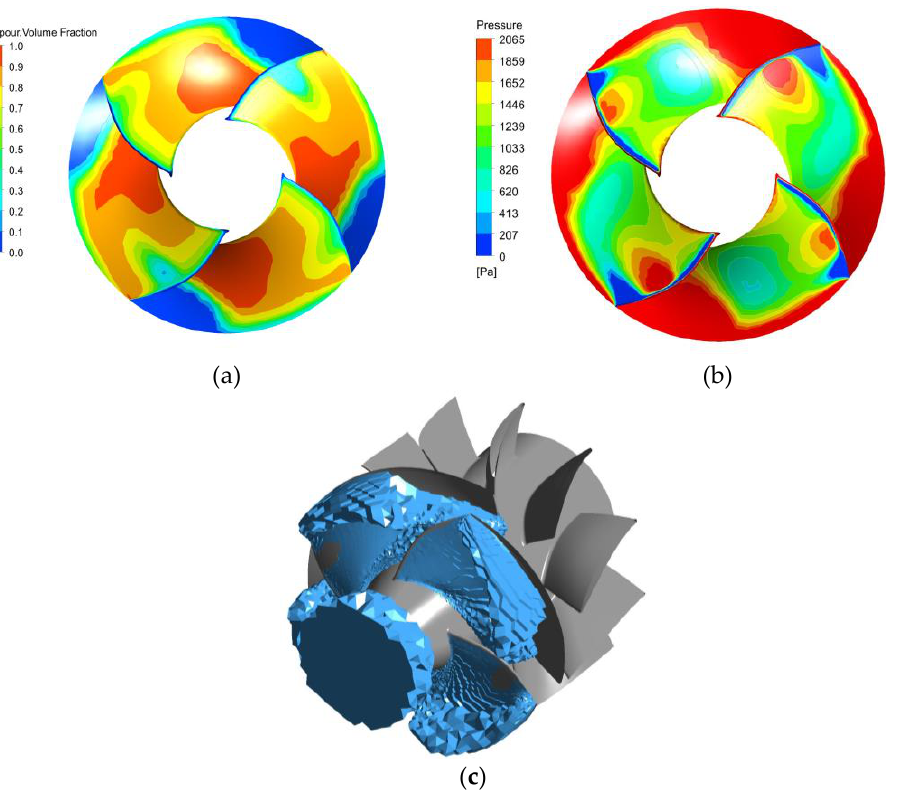
Figure 9. Visualization of CFD calculation results on the suction surface of rimless impeller № 2 ( Q = 0.3 × Q BEP , NPSH3 = 2 m): ( a ) Vapor volume fraction distribution; ( b ) Pressure distribution ( c ) Isovolume of vapor with a concentration of more than 30%.